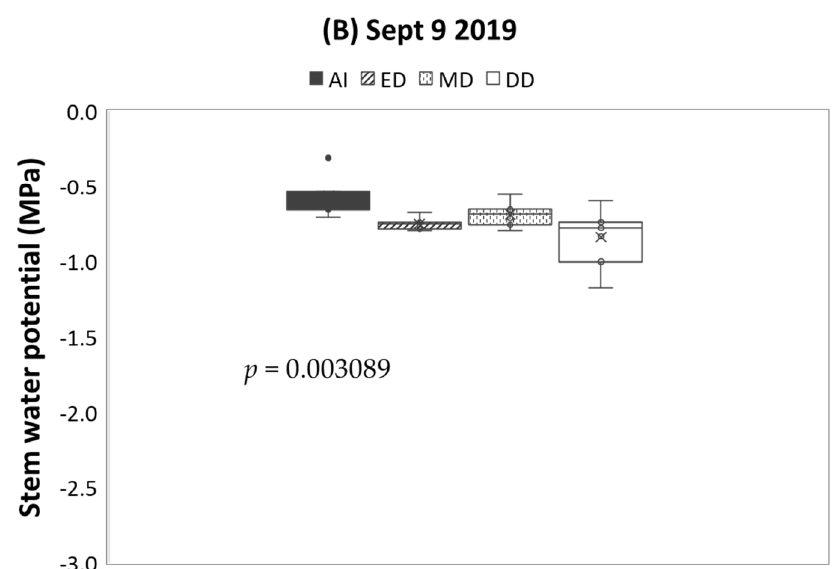
Figure 6. Stem water potential in Ambrosia TM trees in late summer. The data were collected on 6 September (125 days AFB) 2018 ( A ) and on 9 September (128 days AFB) 2019 ( B ), with eight replicates, respectively. The statistical significance between irrigation treatments was analyzed using an ANOVA single-factor model ( p ≤ 0.05). The box shows the minimum, first-quartile, median, third-quartile, and maximum values. The bars with error bars are means ± standard errors. AI = adequate irrigation; ED = early ‐ summer deficit irrigation (DI); MD = middle ‐ summer DI; DD = double ‐ period DI.